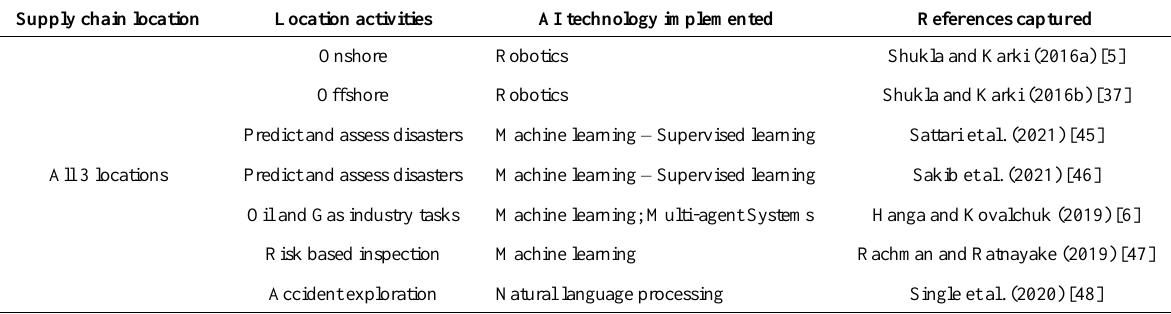
Table 4. Papers focusing on AI technologies applied to activities along the whole supply